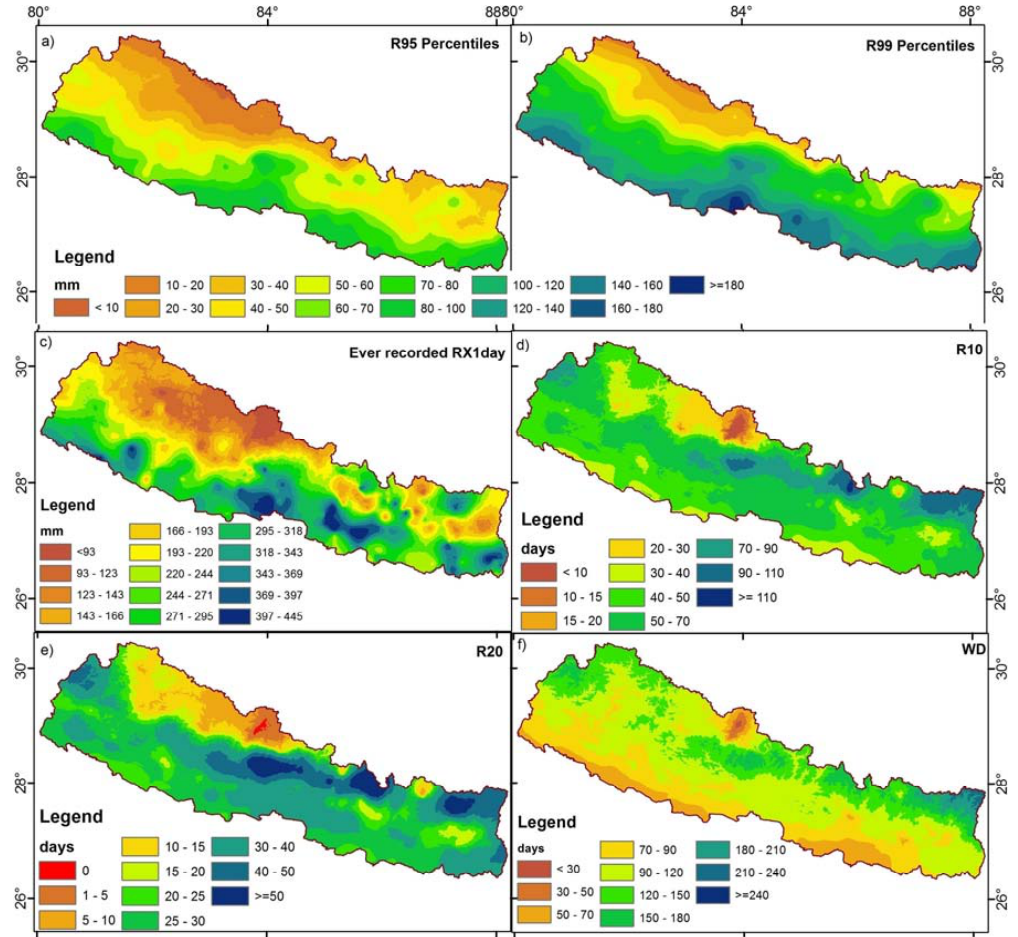
Figure 4. Spatial distribution of ( a ) 95th percentile; ( b ) 99th percentile mean values of daily precipitation; ( c ) ever-recorded one-day extreme precipitation; ( d ) mean annual number of days with precipitation ≥ 10 mm; ( e ) mean annual number of days with precipitation ≥ 20 mm ( f ) mean annual number of days with precipitation ≥ 1 mm (wet/rainy days) over the period of 1981–2010. Note: Legend scales are different.